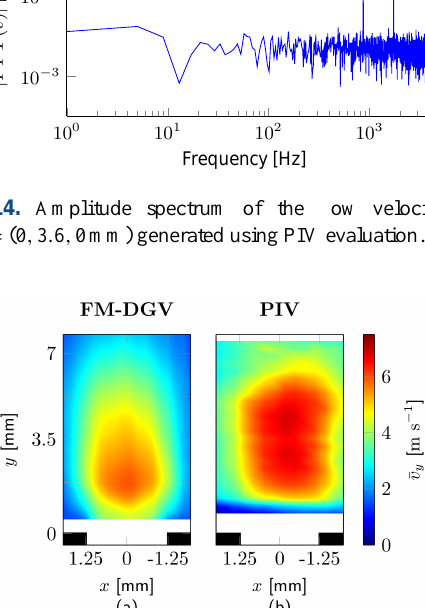
Figure 15. Mean flow velocity ¯ v y at z = 0mm measured with (a) FM-DGV and (b)